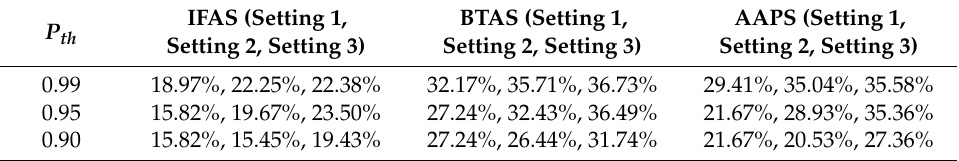
Figure 26. The average energy consumption with P th as variable (setting 1, setting 2, setting 3). Table 17. The improvement of energy consumption compared with the traditional algorithm.